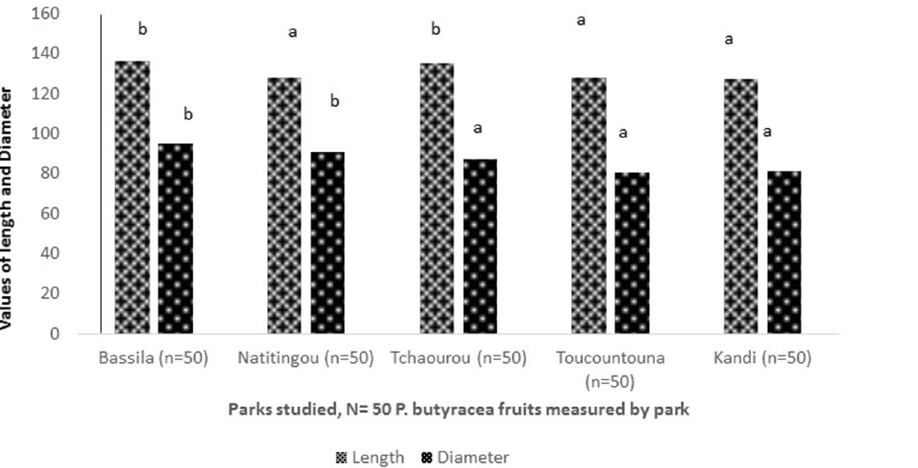
Figure 1. Dimensions of P. butyracea fruits by park collected in June 2020 in